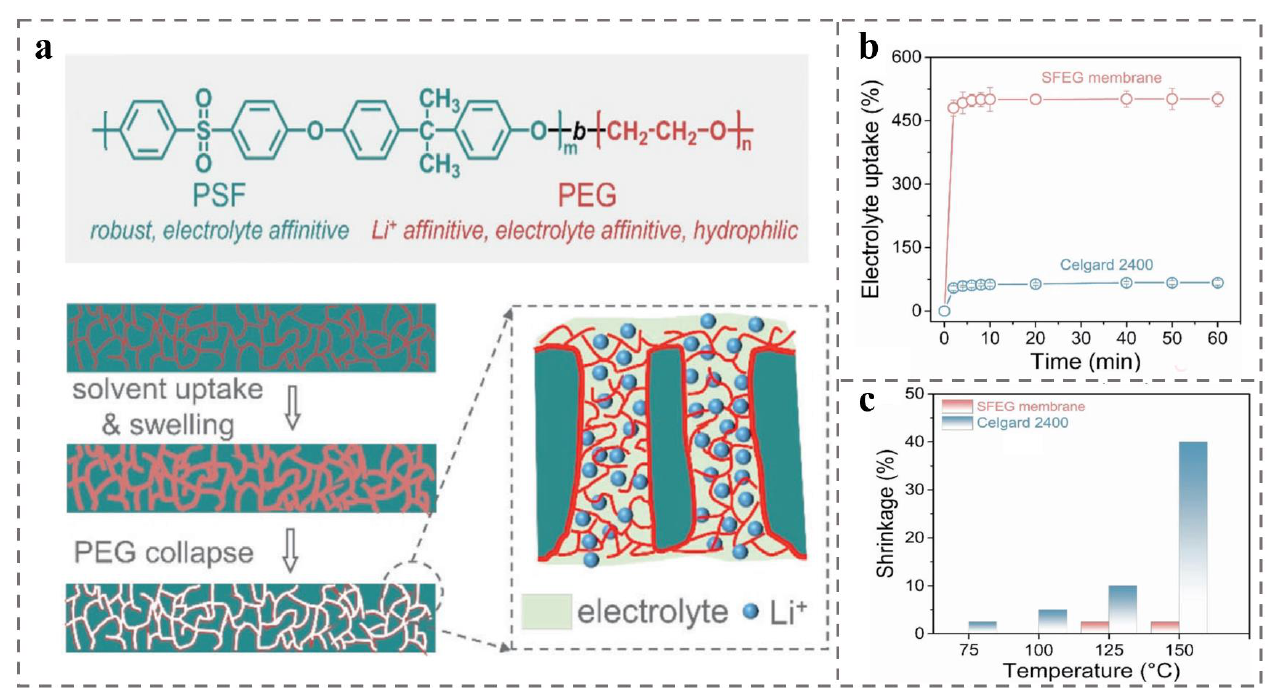
Figure 11. ( a ) Molecular structure of PSF-b-PEG membrane and its selective swelling application in lithium-ion transport. Compared to the Celgard 2400 diaphragm, PSF-b-PEG membrane exhibits exceptional electrolyte uptake performance ( b ) and thermal stability ( c ) [225].